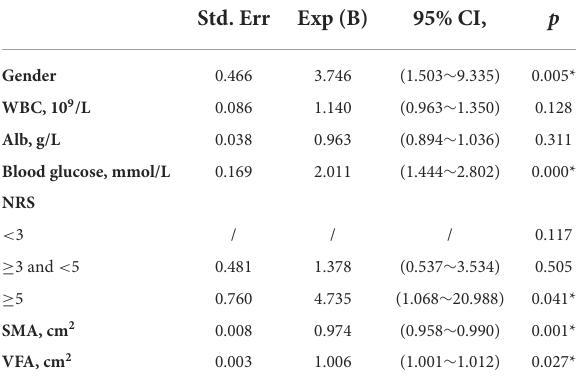
TABLE 3 Multivariate analysis of prognostic factors for AL.